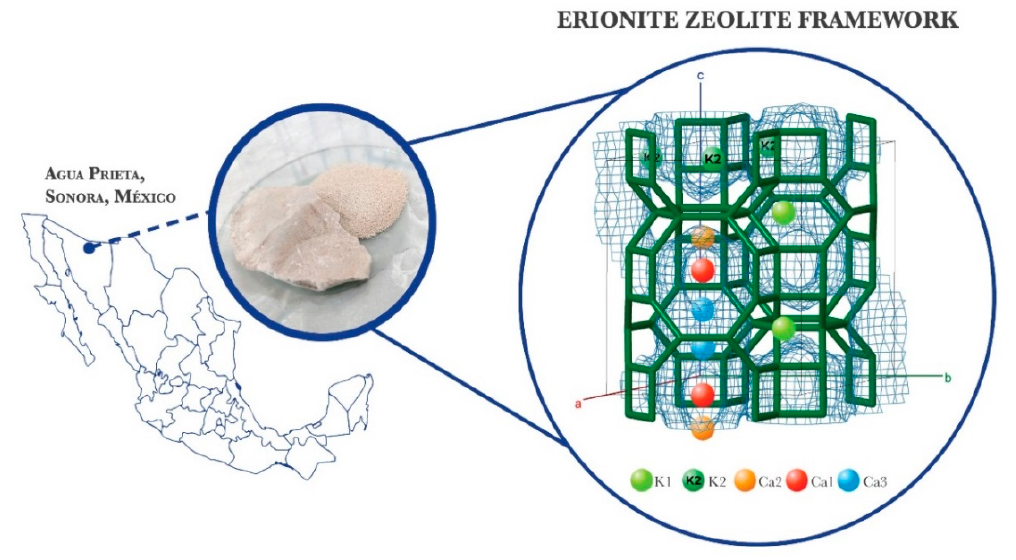
Figure 1. Mexican erionite zeolite framework.